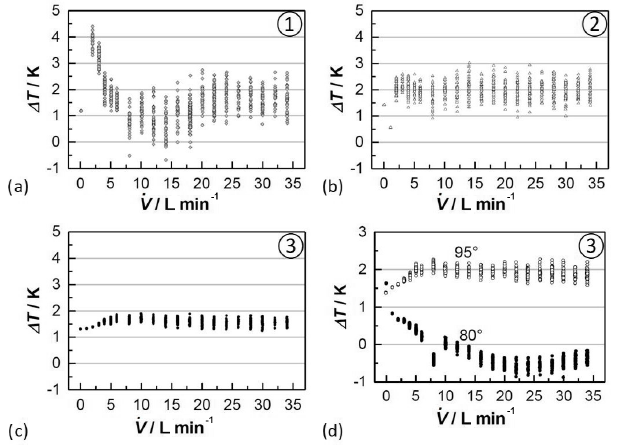
Figure 5. Measured sensor signal ( T abs = 300 ◦ C) with dependence on the gas flow rate (temperature difference (cid:49)T between both sen- sor areas calculated from the measured thermovoltage) for the three different mounting positions described, (1), (2) and (3), (a–c) and for a slightly rotated mounting at position (3) (d) .